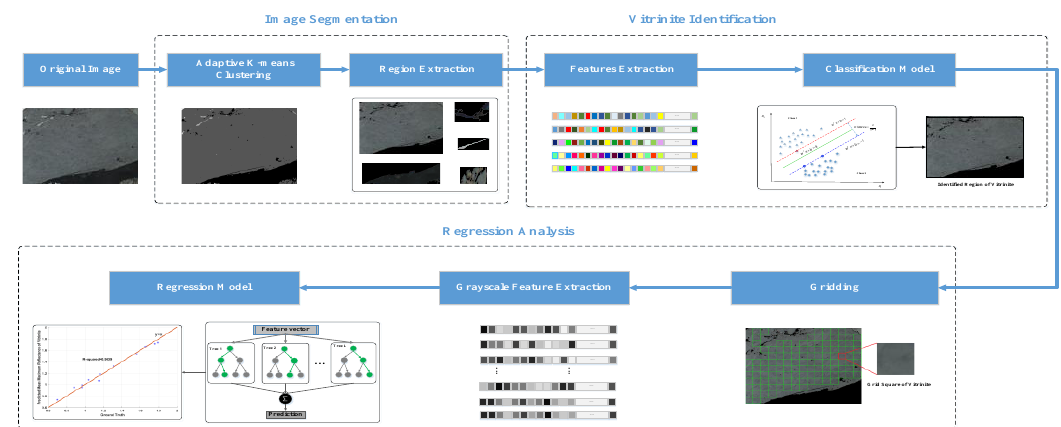
Figure 1. The flowchart of the proposed mean maximum vitrinite reflectance measurement based on machine learning (MMVRML) .